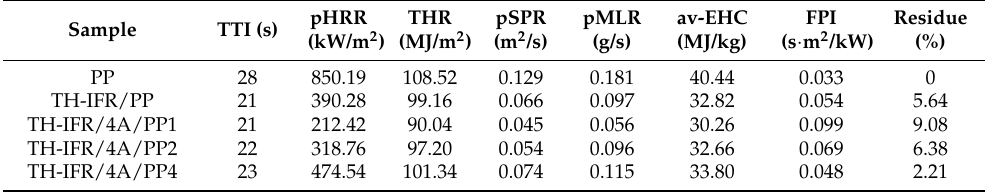
Table 2. The CCT parameters of pure PP, TH-IFR/PP, TH-IFR/4A/PP1, TH-IFR/4A/PP2 and TH- IFR/4A/PP4 FR material.